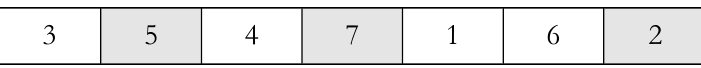
Figure 6. Random produced seed around the given